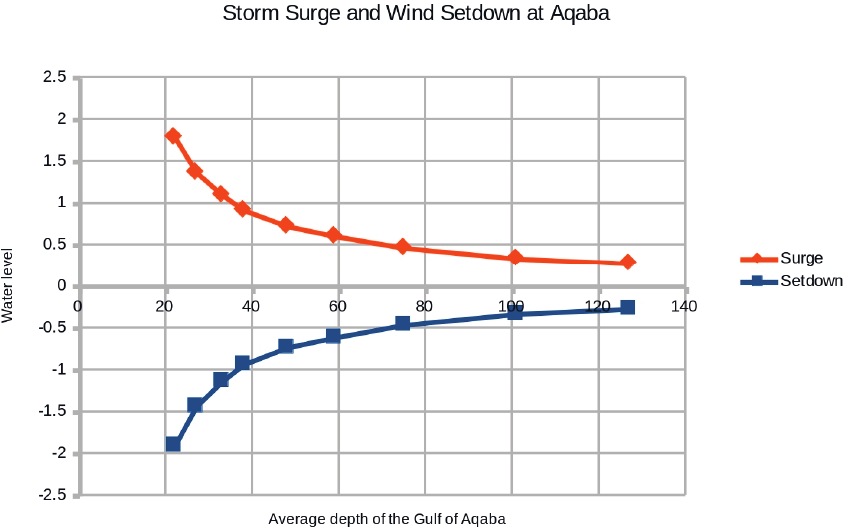
Figure 12. Storm surge and wind setdown at Aqaba when the Gulf of Aqaba is made shallow. To further illustrate the effect of water depth on storm surge, experiment RS9 reduced the depth of the Red Sea proper (south of Sinai) and measured the resulting water levels at Adabiya for wind angles of 120° and 300° (Cartesian). Storm surge at Adabiya rose to 1.95 m above sea level, and wind setdown dropped to 2.01 m below sea level. Thus the water displacement for a shallow Red Sea proper increased by 27% and 28%,